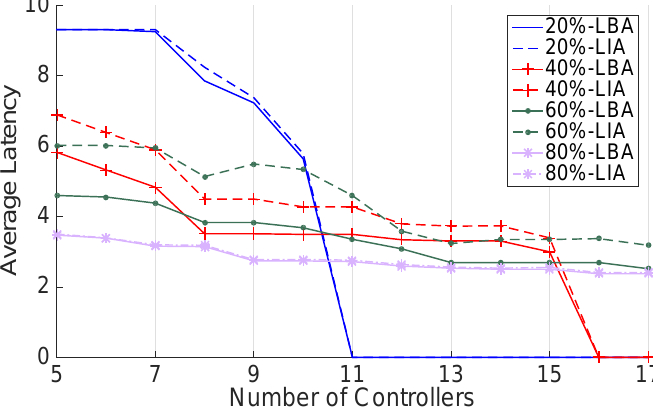
Figure 9. Average SFD-to-controller latency with different SDN deployment ratio.